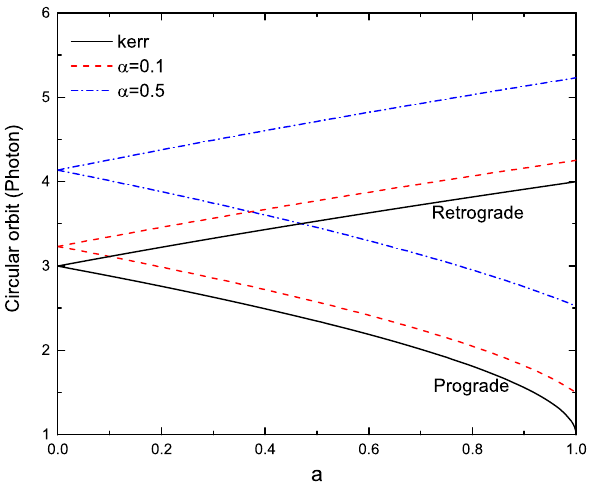
Fig. 4 Circular photon orbit of the Kerr black hole and the Kerr-MOG black hole. The solid line is the case of the Kerr black hole. A circular photon orbit is plotted on some intrinsic angular momentum a and parameter α . In particular, it has a value greater than 3, different from theSchwarzschildmetric,when a iszero.Moreover, thecircularphoton orbit of an extreme Kerr black hole ( a = 1) has 1 but the Kerr-MOG black hole shows r c > 1